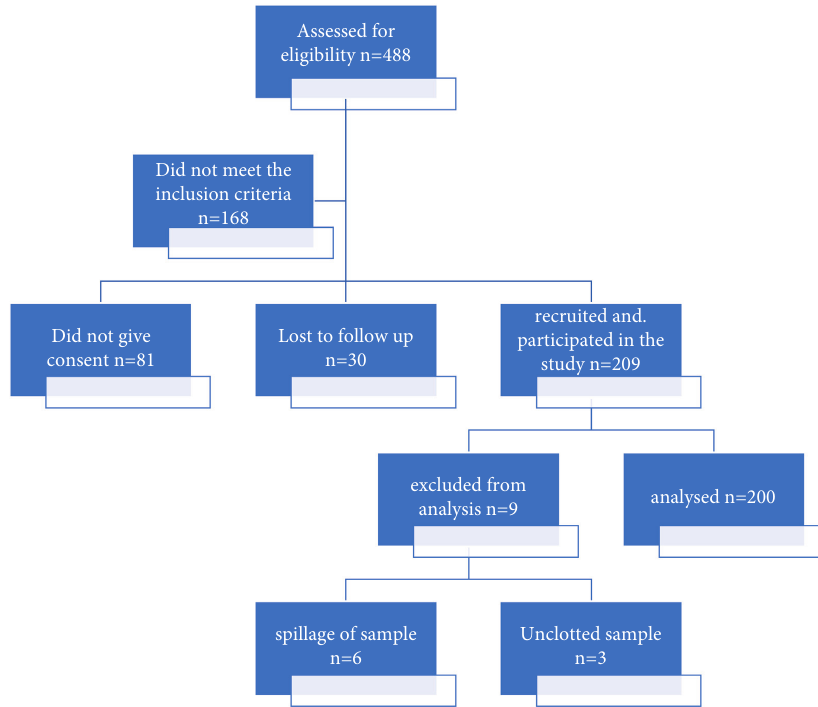
Figure 1: Flow chart of the study.